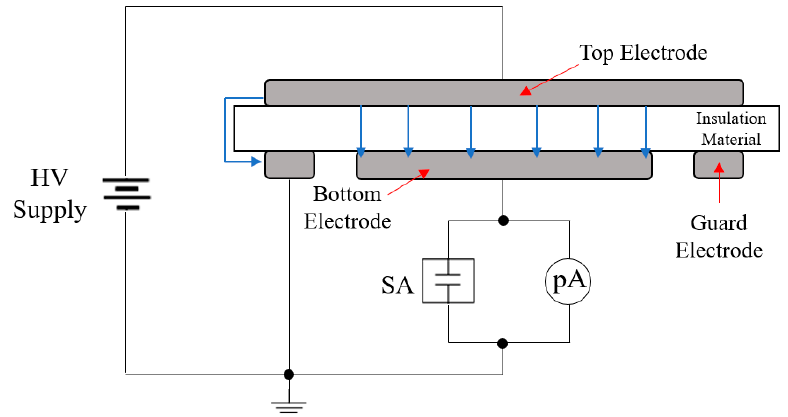
Figure 2. Circuit diagram for measuring the volume resistivity.